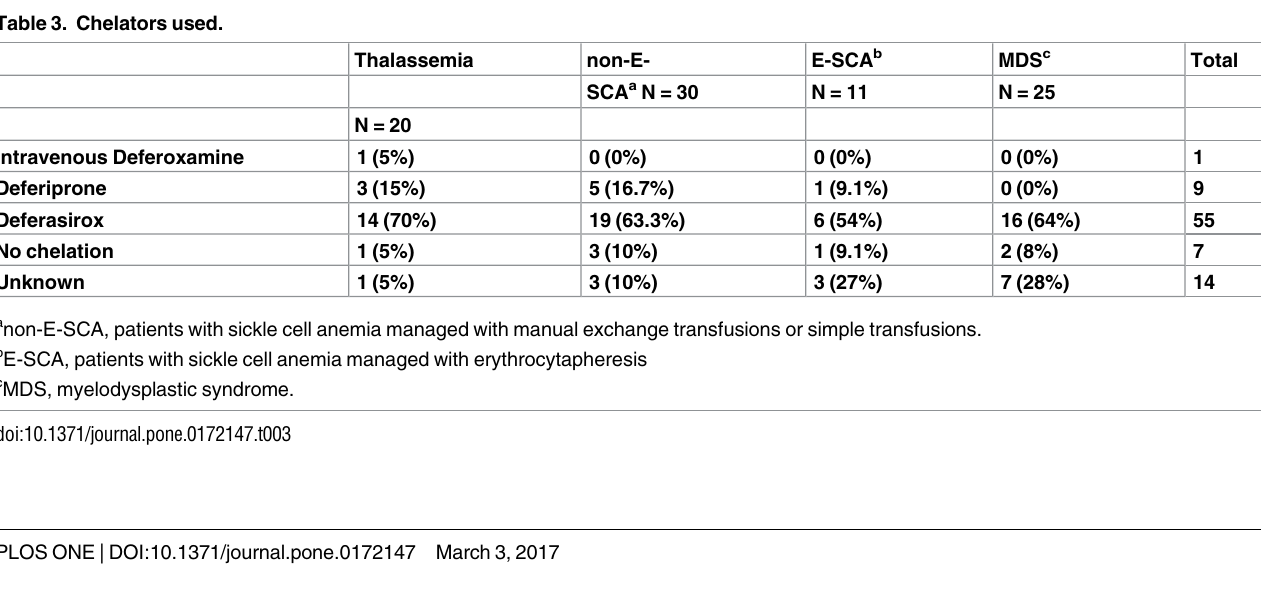
with MDS, 37.5% of patients with thalassemia, 30% of non-E-SCA patients, and 60% of E-SCA patients. Table 4 reports the data on blood iron variables, LIC, and T2 (cid:3) . LIC was significantly elevated in all four groups (median, 10.4-15.2 mg/g dry weight; nor- mal, 0.4-2.2 mg/dry weight), with no significant difference across groups at the time of the study ( P = 0.29).